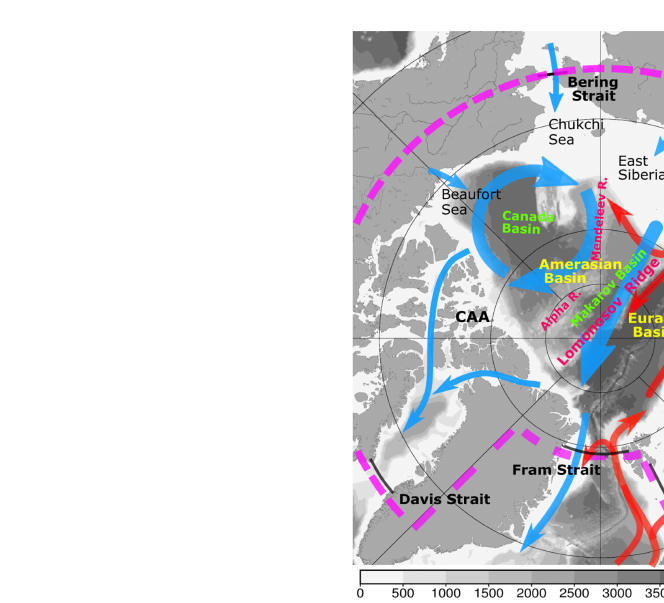
FIGURE 1 | Schematic of Arctic Ocean circulation. The blue arrows denote upper ocean circulation, and red arrows denote Atlantic Water circulation. The background gray color denotes bottom bathymetry. The magenta dashed line indicates the Arctic boundary for replacing atmospheric forcing in the sensitivity experiments used in Section